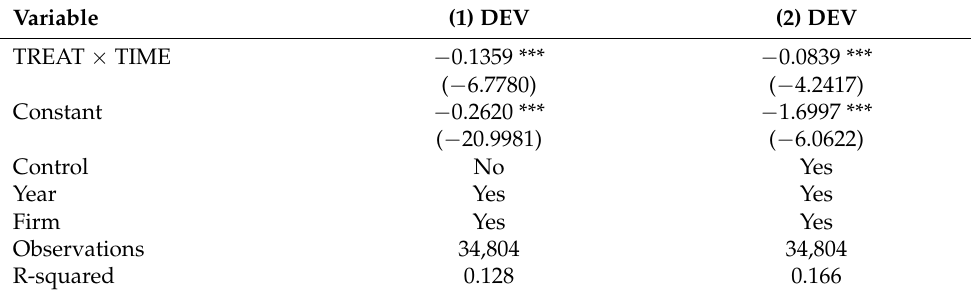
Table 11. Propensity score matching.